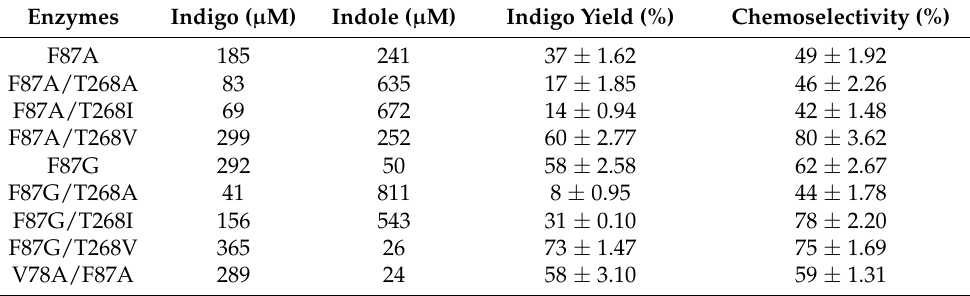
Table 2. The amount of indigo and indole after 10 min reaction and the chemoselectivity to indigo estimated by HPLC by P450BM3